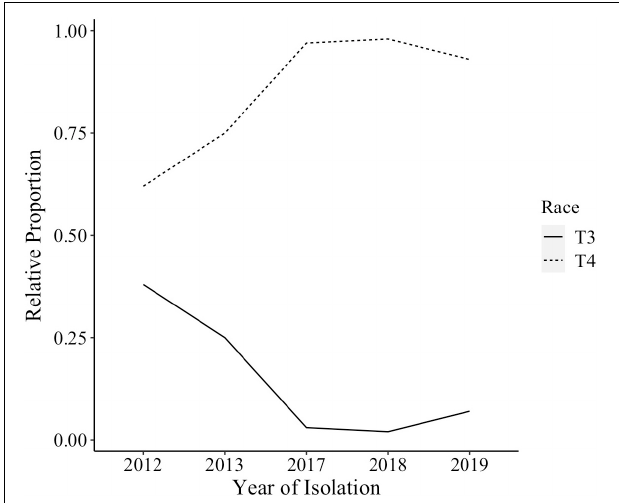
FIGURE 1 | Xanthomonas perforans race composition for strains isolated from tomatoes between 2012 and 2019. X. perforans strains isolated in 2012, 2013, 2017, 2018, and 2019 were screened using hypersensitive response (HR) assay to determine their race. By 2017, 93% of all X. perforans strains were categorized as race T4 based on hypersensitive response and PCR amplification of avrXv3 .